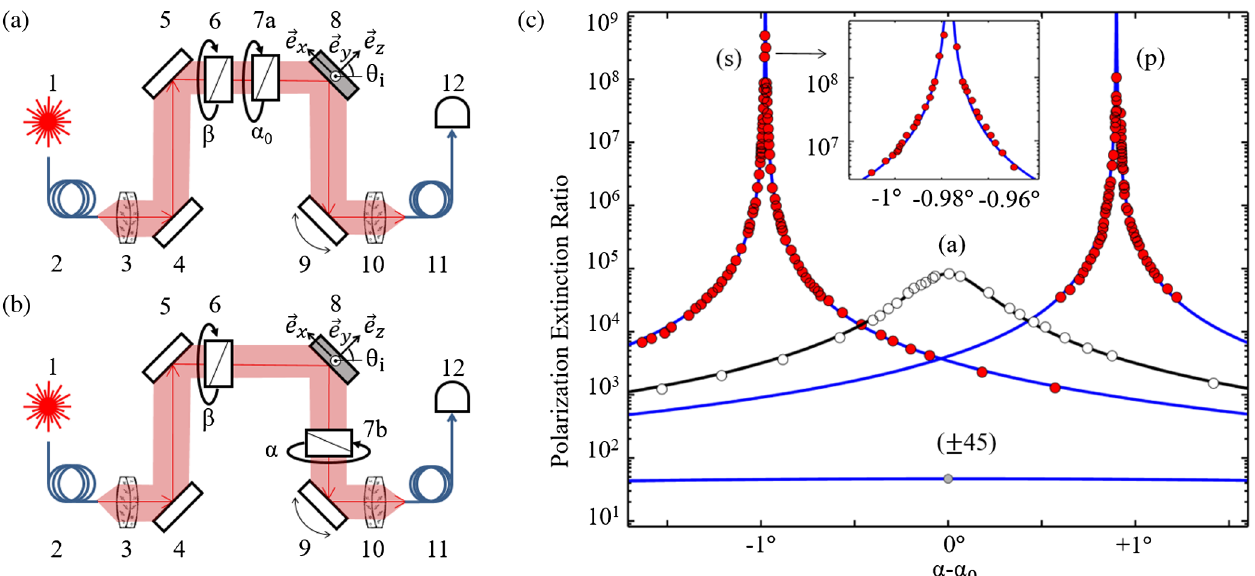
FIG. 1. (a),(b) Cross-polarization extinction setup in a confocal microscope arrangement setup as described in the text. (c) Measured and modeled linear polarization extinction ratio for both p - and s -polarized beams around cross-polarization conditions obtained by placing the analyzer before (a) and after (b) a protected silver mirror. A giant extinction enhancement of more than 3 orders of magnitude is obtained in configurations s and p with the reflecting surface placed between crossed polarizers. The inset is a magnification of the polarization extinction near maximum for the s polarization. An angular shift of the location of maxima of extinction is systematically found for the s and p polarization with respect to the reference. When the linear polarization is tilted at (cid:2) 45 ° from the plane of incidence, the extinction reduces dramatically down to about 41 as shown with the lowest curve and data